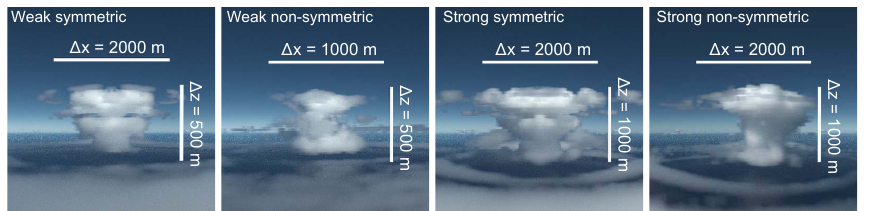
Figure 2. Visualization of the four single cloud simulations (first: weak symmetric; second: weak non-symmetric; third: strong symmetric; fourth: strong non-symmetric). The snapshot of the cloud field is taken at 40min of the simulation of the 3-D Thermal NCA case. The visualization was performed with the 3-D radiative transfer model MYSTIC (Mayer, 2009). The clouds in the background are a feature of the visualization and do not occur in the LES simulation of the single clouds. Clouds close to the surface are neglected in our analysis. Please note that the clouds are rather oblate, although they appear stretched due to the perspective used in this visualization.